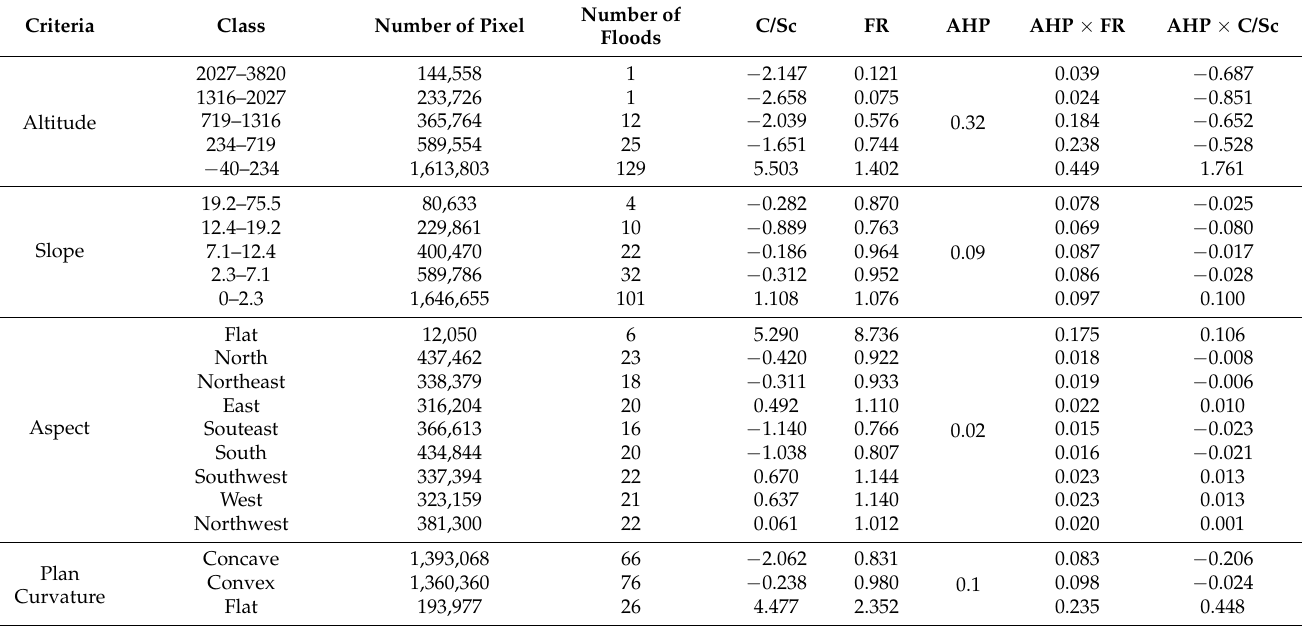
Table 3. Relationship between influential factors and flood